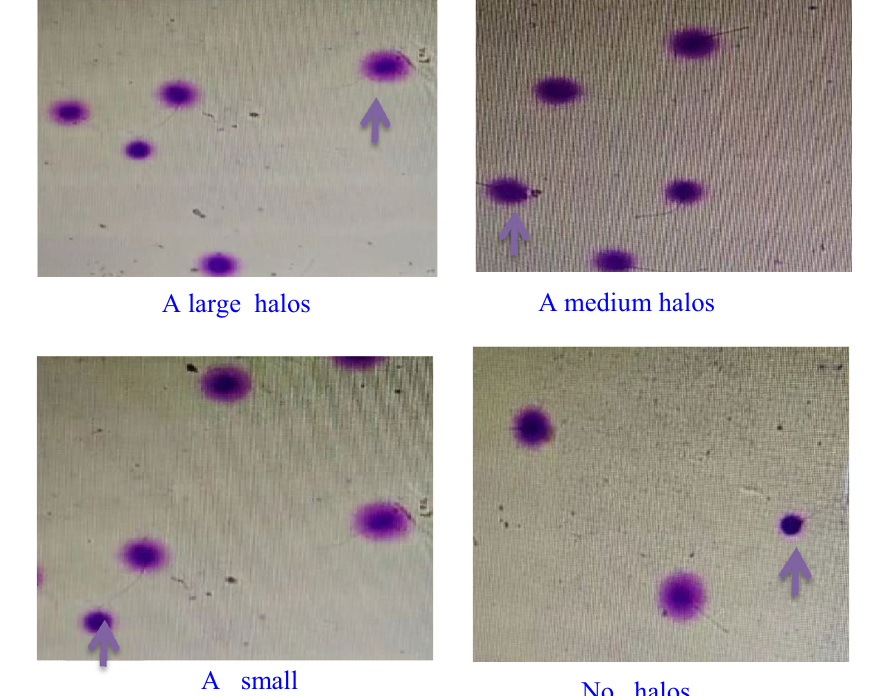
Figure 1. SCD test of human